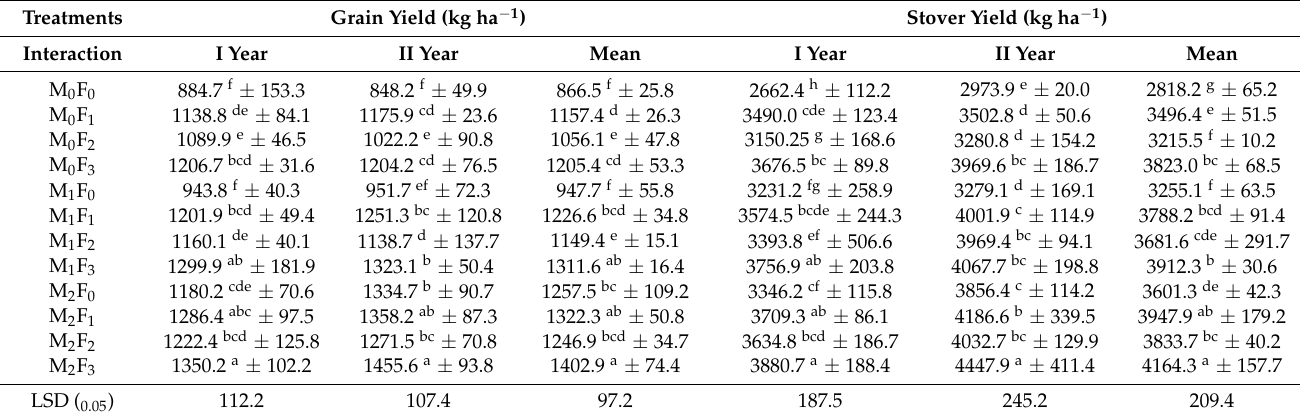
Table 2. Effect of different levels of Zn, Fe and Mo molecules on the grain and stover yield of